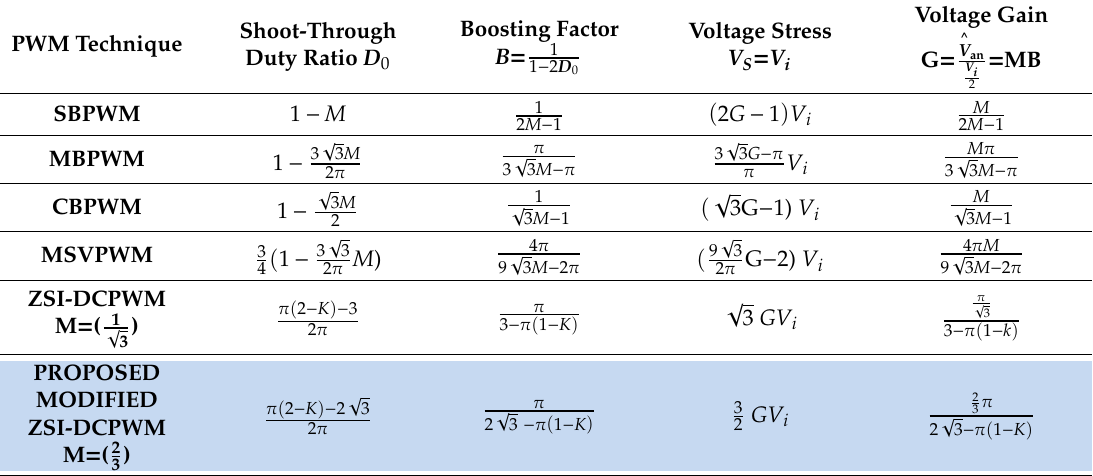
Table 1. ZSI modulation techniques relations.